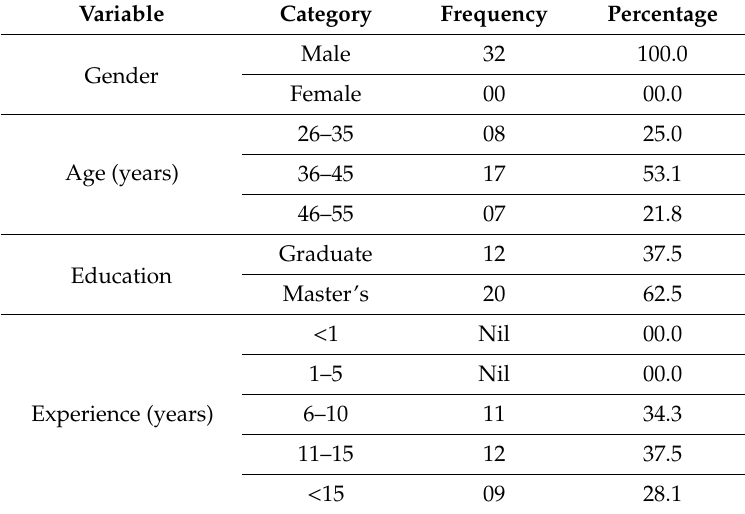
Table 1. Information about the respondents, n =